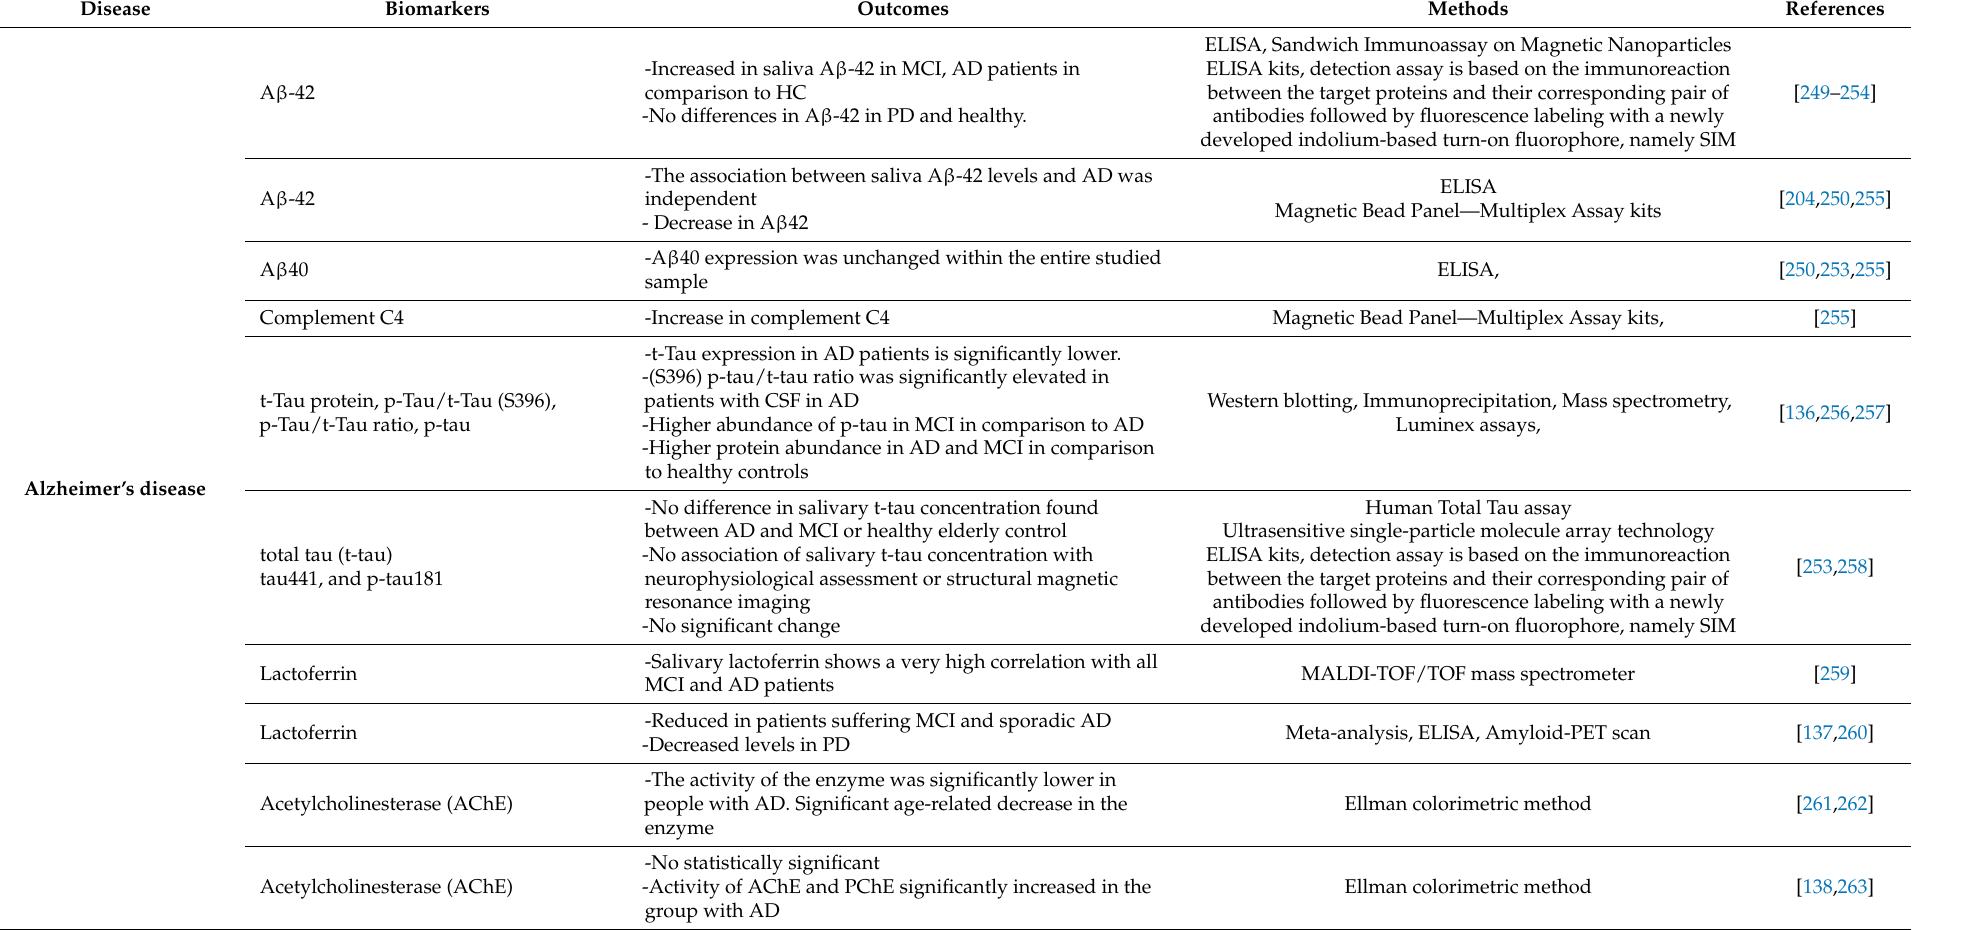
Table 4. A detailed list of studies highlighting salivary biomarkers in neurodegenerative